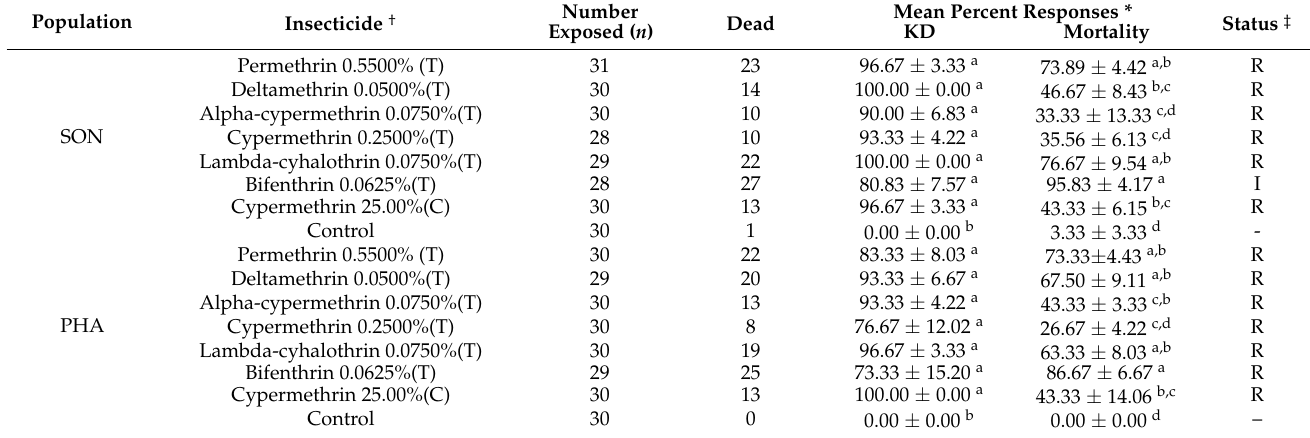
Table 2. Wild adult Stomoxys calcitrans (males and females), sampled from Songkhla (SON) and Phattalung (PHA) populations, mean knockdown (KD) and mortality rates (percentage ± SE) within 60 min and 24 h following 30 min exposure to recommended concentrations of six technical-grade and one commercial-grade insecticide in WHO cone bioassay.